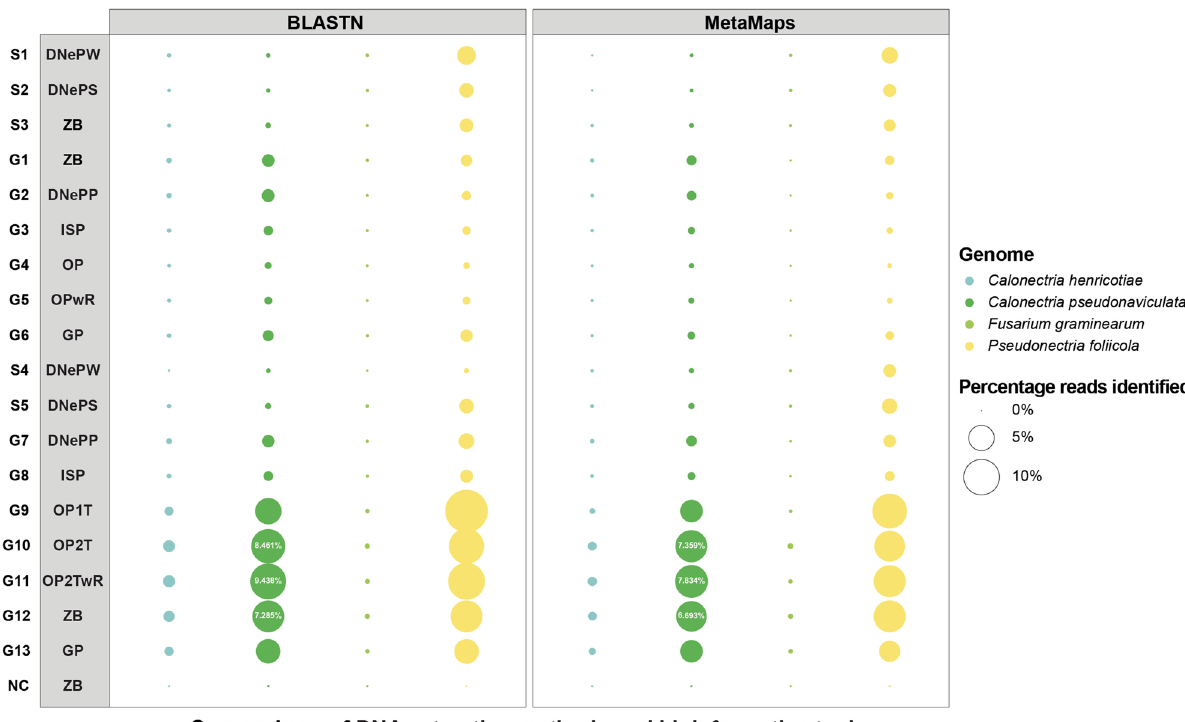
Figure 2. Bubble plot showing the percentage of sequencing reads assigned to four fungal species in each sequenced sample. The column on the left displays the sample IDs and the column to its right displays the abbreviations of DNA extraction kits (see Table 1). Bubble size is proportional to the percentage of reads assigned to the four species listed on the right based on the tools BLASTN and MetaMaps using a small fungal database containing one genome per fungal